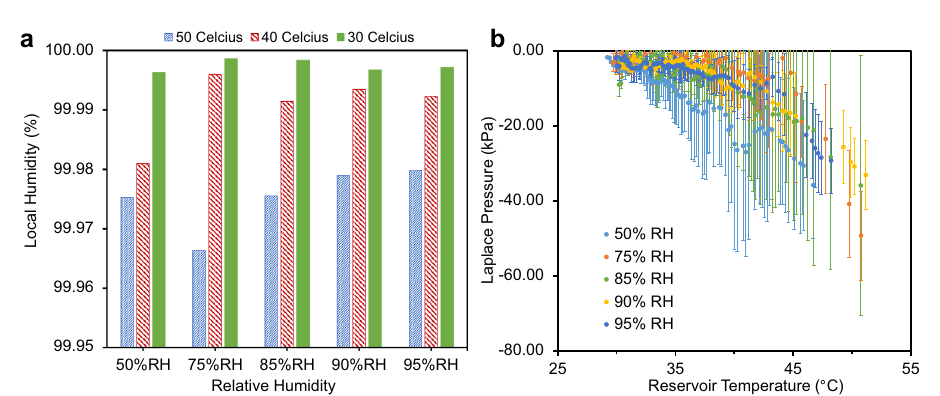
Figure 3. Local humidities and Laplace pressures for the short tree experiments. (a) The local humidity immediately above the water menisci within the nanopores approached 100%. This is due to the slow, diffusive transpiration rate, which requires a very low Laplace pressure to conserve mass. By balancing this small Laplace pressure with the corresponding Kelvin pressure, a high local humidity is obtained. Physically, this high humidity is achieved by the menisci partially retreating to concentrate vapor within the nanopores, at which point the menisci position stabilizes. (b) Estimated Laplace pressures generated by the concave water menisci under five ambient relative humidities. Values were obtained by summing the three pressure drops across the tree required to achieve a theoretical ow rate equal to the measured transpiration